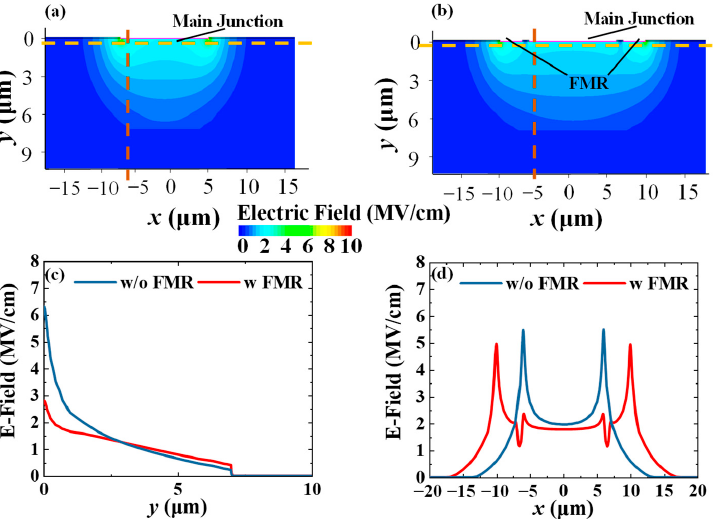
Figure 4. The electric field at 810 V. ( a , b )The 2D distribution ( a ) without FMR and ( b ) with FMR. ( c ) Vertical cutline profile in ( a , b ). ( d ) Lateral cutline profile in ( a , b ). Figure 4a displayed the electric field distribution at 810 V for the SBD structure with an epitaxial thickness of 7 μ m and an epitaxial layer doping concentration of 10 16 cm − 3 without the FMR structure. Figure 4b displayed the same structure as the FMR structure at the same voltage. Figure 4c,d gives the vertical and lateral profile of the electric field. It is shown that the peak electric field of the main Schottky junction is substantially lower, while the peak electric field of the FMR edge is still lower than that of the peak electric field without the FMR structure. With the help of FMR, the breakdown voltage of the structure in Figure 4a is 810 V and in Figure 4b is 1258 V, which is 1.5 times higher than without FMR. The relationship between breakdown voltage and spacings between FMRs and the main Schottky junction was first studied. To simplify our discussion, only one ‐ FMR and two ‐ FMR cases were discussed. Figure 5 shows the simulation results for relevant struc ‐ tures with the structural parameters of L epi = 7 μ m. In the one ‐ FMR case, as the spacing increases, the breakdown voltage gradually decreases until it finally drops to the same level as that of no FMR, as shown in Figure 5a. This is because, with larger spacing, the FMR will have less effect on the electric field distribution at the edge of the main Schottky junction, as shown in Figure 5c. When another FMR is added, the inner spacing has more influence on the breakdown voltage than the outer one, as shown in Figure 5d, where structures in group A were changing the inner spacing and those in group B were chang ‐ ing the outer one. The reference value of the normalized breakdown voltages in Figure 5d. is 1475 V with N epi = 10 16 cm − 3 for A1 and B1 and 1238 V for A2 and B2 with N epi = 2 × 10 16 cm − 3 . The device structure used for the normalization breakdown voltage had inner and outer FMRs with a width of 1 μ m and an inter ‐ FMR spacing of 1 μ m. The inner and outer inter ‐ FMR spacings were varied for the other devices. The outer spacing also influ ‐ ences the breakdown voltage, which, however, is minute. The effect of the outer FMR can be understood as an independent FMR optimizing the electric field distribution at the edge of the main Schottky junction. The outer FMR is already in a position where the impact on the breakdown voltage is minimal. However, it should be noted that the outer FMR will optimize the electric field distribution at the edge of the inner FMR, as electric field profile shown in Figure 5f. So, spacings between the FMRs as small as possible are still needed to reduce the peak electric field intensity at the edge of the inner FMR.